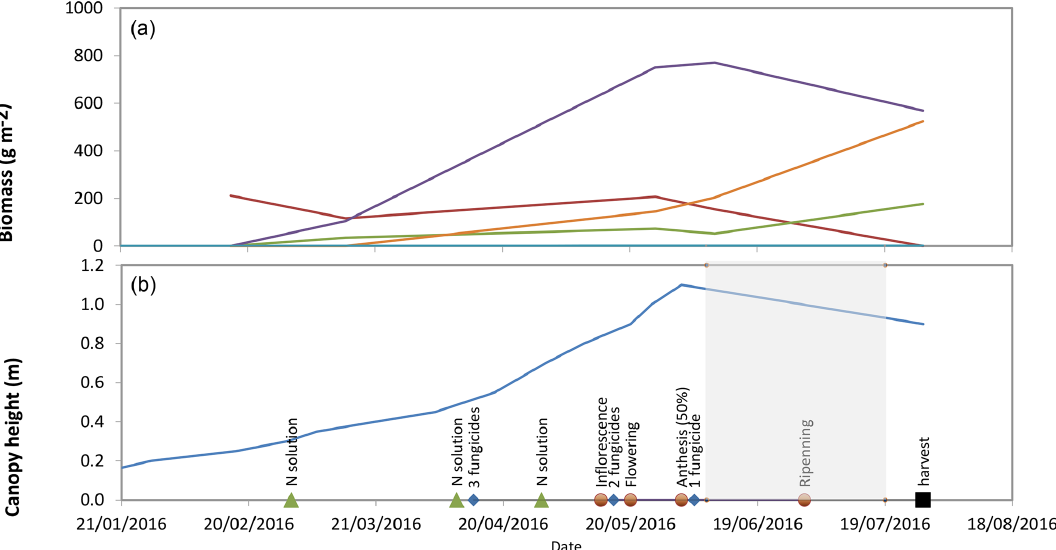
Figure 3. (a) Evolution of the aboveground biomass of different plant compartments. (b) Crop height, crop developmental stages and farmer activity. The experimental period is highlighted in grey